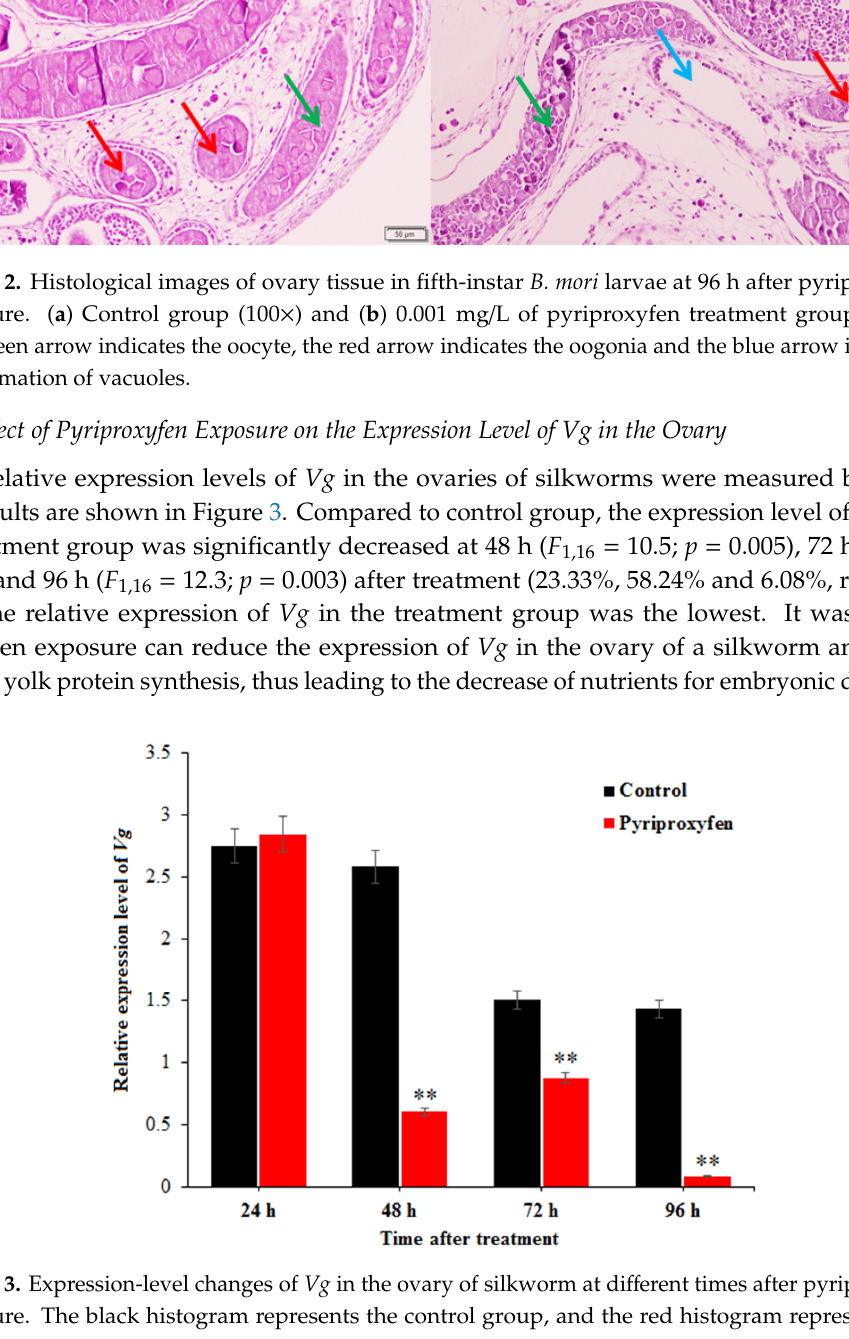
treatment group. The x -axis represents the time after pyriproxyfen exposure, and the y -axis represents